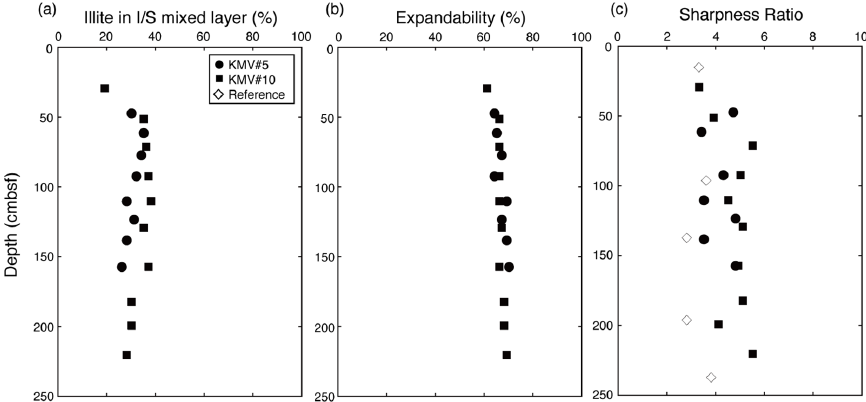
Figure 7. Vertical profiles of ( a ) illite in the I/S mixed layer; ( b ) expandability in clay-size fractions from KMV#5 and KMV#10 and ( c ) Weaver’s Sharpness Ratio for the mud-volcano sediments and the reference-site sample.